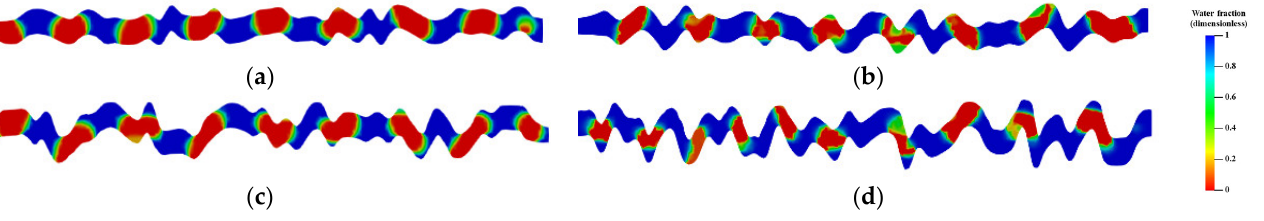
Figure 10. Snapshots of gas and water distribution in single-fracture with tortuosity of ( a ) 1.1; ( b ) 1.2; ( c ) 1.3; and ( d ) 1.5.